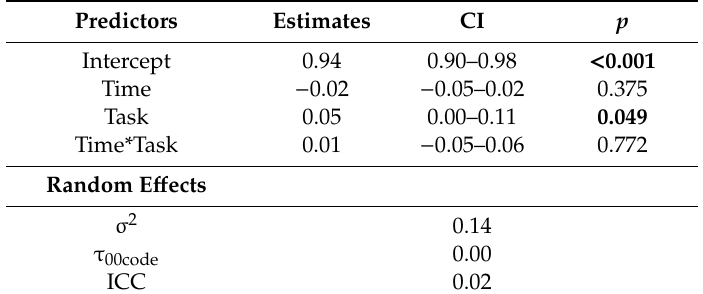
Table A4. Estimates and significance values for fixed-e ff ects in the RER